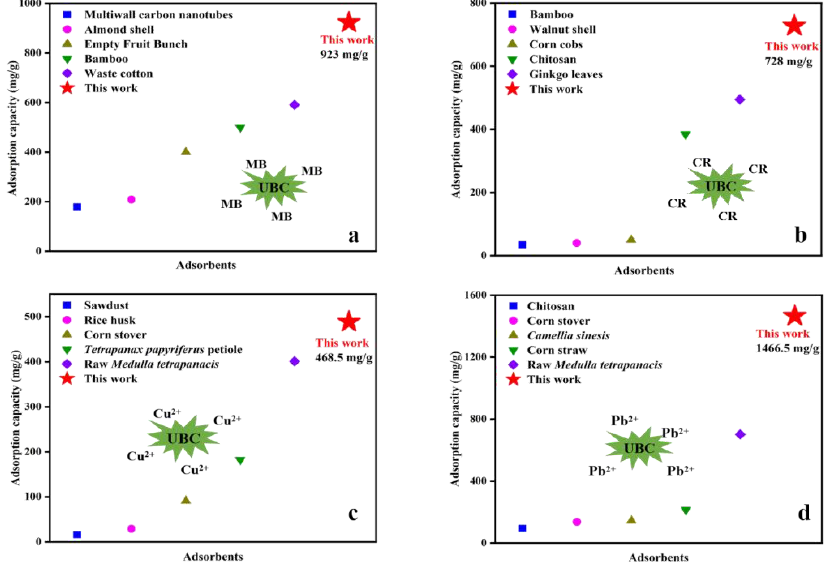
Figure 4. Adsorption capacity of various biomass adsorbents for MB ( a ), CR ( b ), Cu 2+ ( c ), and Pb 2+ ( d ).